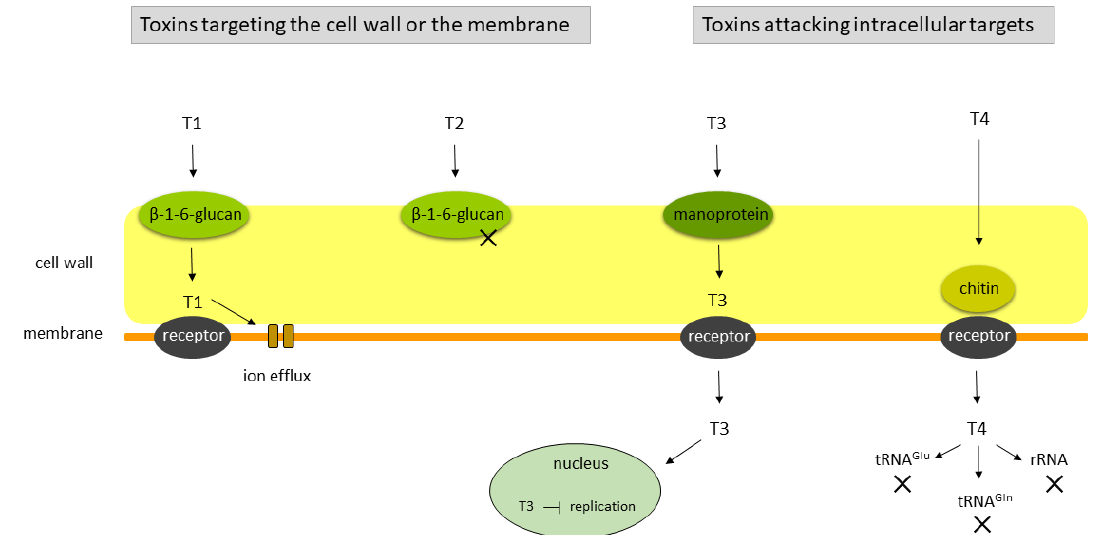
Figure 2. Modes of action of killer toxins according to Klassen et al. (2017), modified [61]. Killer toxins can be divided into four categories regarding the cell target. The T1 and T2 toxin types use β -1,6-glucan as the primary cell wall receptor (in figure, toxins targeting the cell wall or the membrane).